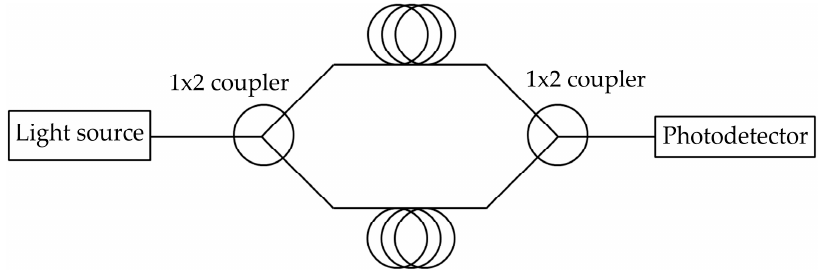
Figure 2. A basic connection of the Mach-Zehnder interferometer.